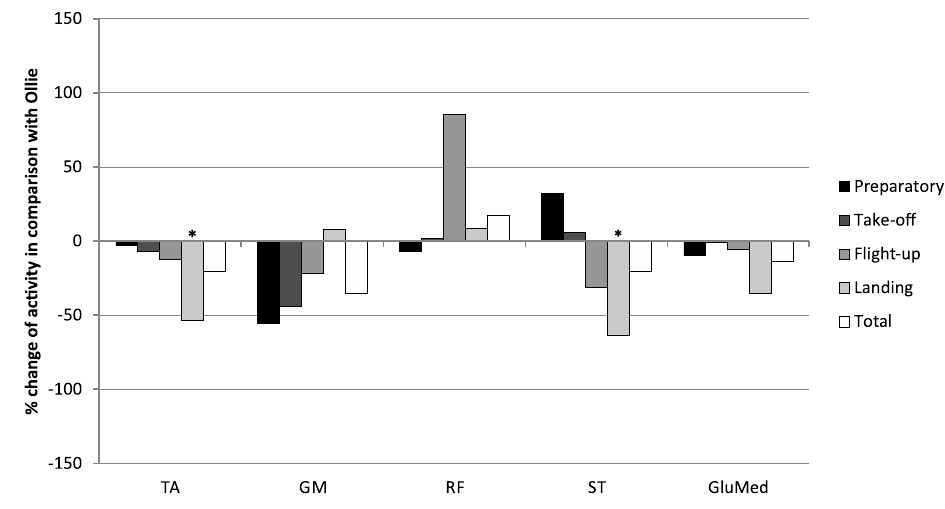
Figure 1. Front lower limb muscle activity during switchstance Ollie in comparison with Ollie. TA = tibialis anterior, GM = gastrocnemius medialis, RF = rectus femoris, ST = semitendinosus, GluMed = gluteus medius. * p < .05